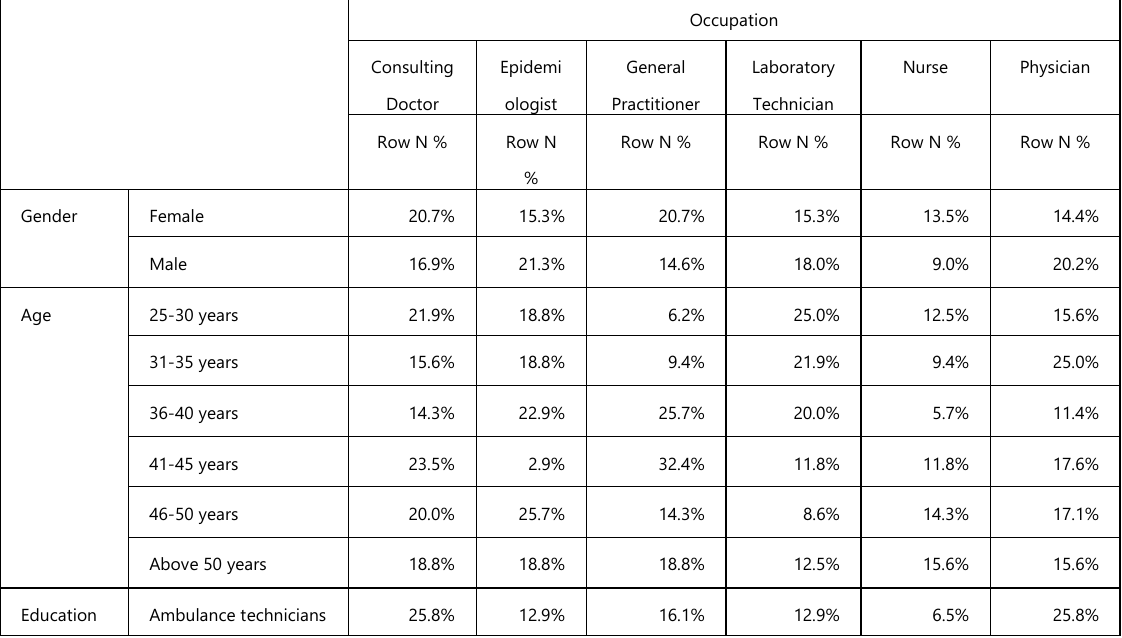
Table 1: Demographic Characteristics of Survey Participants (Source: Authors’ calculation)